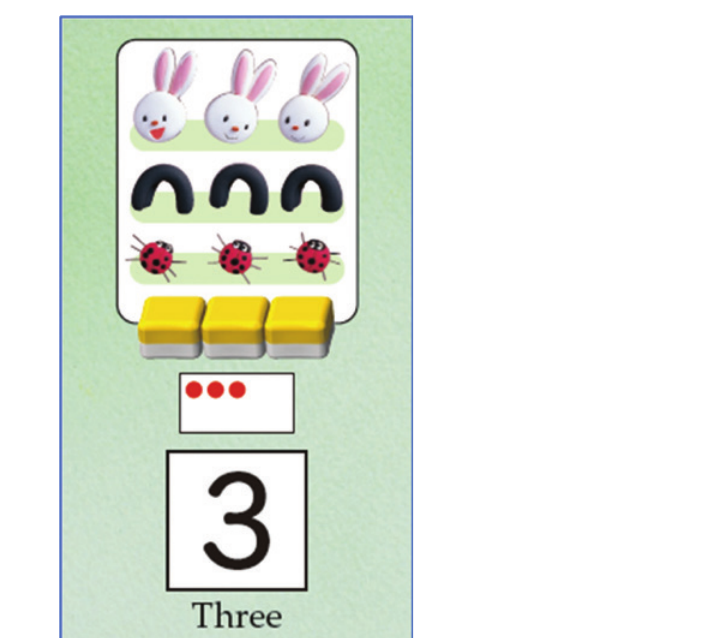
Figure 1: Early counting arranged horizontally in a Japanese textbook, to encourage number line